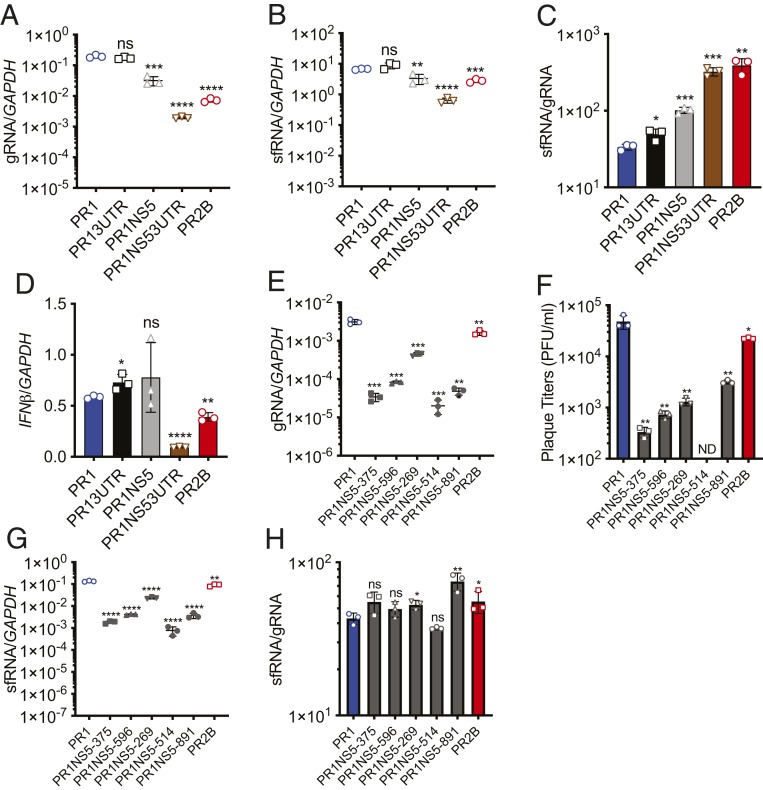
NS5 mutations result in retardation of virus gRNA and augments the sfRNA:gRNA ratio. (A–D) Quantification of gRNA levels (A), sfRNA levels (B), sfRNA:gRNA ratios (C), and mRNA expression of IFN-β (D) in primary monocytes by RT-qPCR. (E) Quantification of gRNA levels in infected A545 cells using qPCR. (F) Plaque-forming units determined from supernatant of infected cells. (G) Quantification of sfRNA levels in infected A545 cells using qPCR. (H) sfRNA:gRNA ratios quantified from gRNA and sfRNA levels. Data are presented as mean ± SD. *P < 0.05; **P < 0.01; ***P < 0.001; ***P < 0.0001, unpaired t test. ns, not significant.